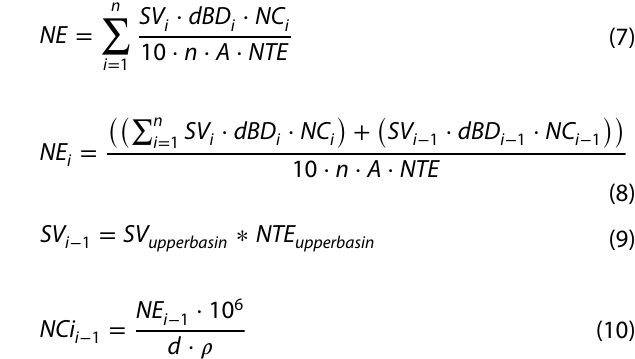
Fig. 9 Methodology for estimating nutrient fluxes to the sea in river basins with intermittent